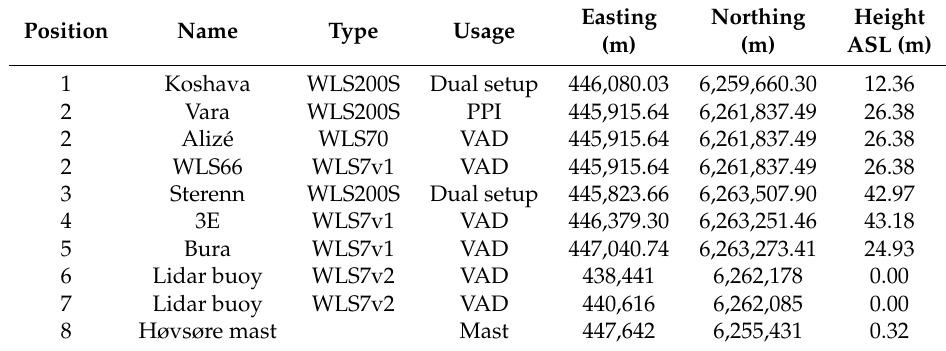
Table 1. Positions, coordinates (UTM WGS84, Zone 32V), types and main scanning strategies (usage) of the lidars during the RUNE campaign (see details in the text), including the information of the Høvsøre meteorological mast. The lidar buoy was used at two positions. The type is the commercial name given by the lidar manufacturer Leosphere (Orsay, France).